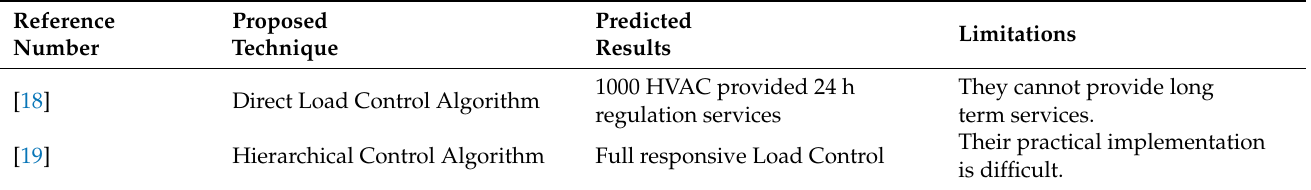
Table 3. Comparative Analysis of Control Algorithms for Frequency